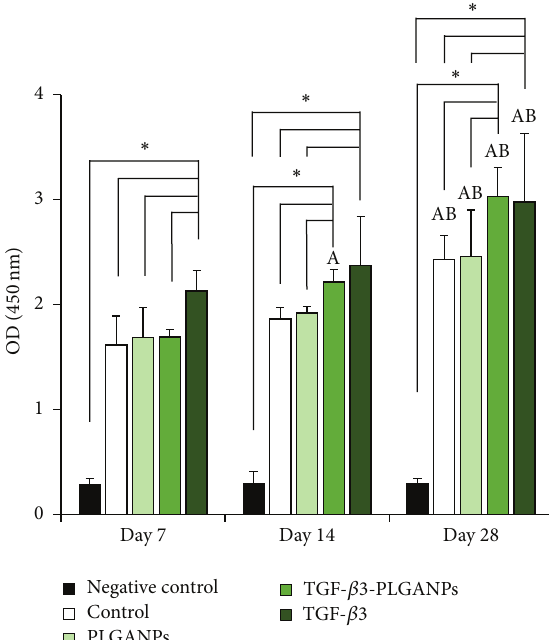
Figure 5: CCK-8 result of the MSCs cultured in the dextran/gelatin hydrogel encapsulated with no supplement (control), 1000 𝜇 g/mL blank PLGANPs (PLGANPs), 1000 𝜇 g/mL TGF- 𝛽 3-loaded PLGANPs (TGF- 𝛽 3-PLGANPs), and the hydrogels with no supplements cultured in the medium containing 10ng/mL TGF- 𝛽 3 (TGF- 𝛽 3) for 7, 14, and 28 days. The hydrogels with no seeded cell were chosen as the negative control. The data were expressed as the mean ± SD ( 𝑛 = 4 ). The samples indicated with ( ∗ ) had a significant difference between the two groups ( 𝑝 < 0.05 ). The samples indicated with (A) had a significant difference compared to the same group on day 7 ( 𝑝 < 0.05 ) and (B) had a significant difference compared to the same group on day 14 ( 𝑝 < 0.05